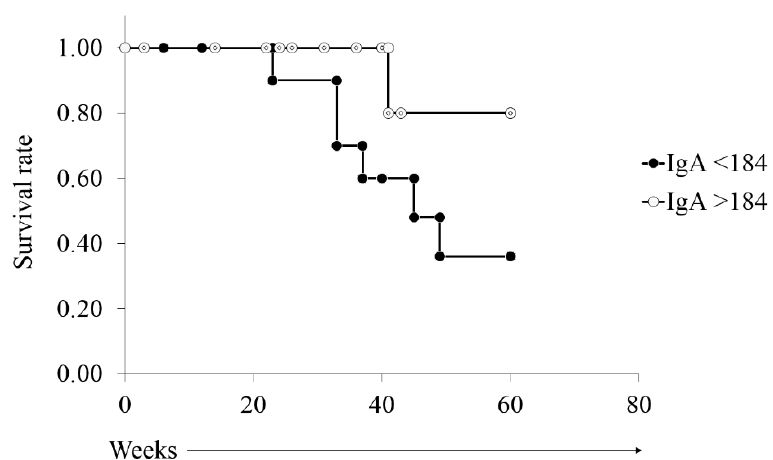
Figure 3. Kaplan–Meier plots of patients stratified by serum IgA of 184 mg / dL. Patients with serum IgA below184 mg / dL had worse survival than patients with IgA above 184 mg / dL (log-rank test, p = 0.06). Table 7. Clinical findings in patients with IgA lower and higher than 184 mg / dL.